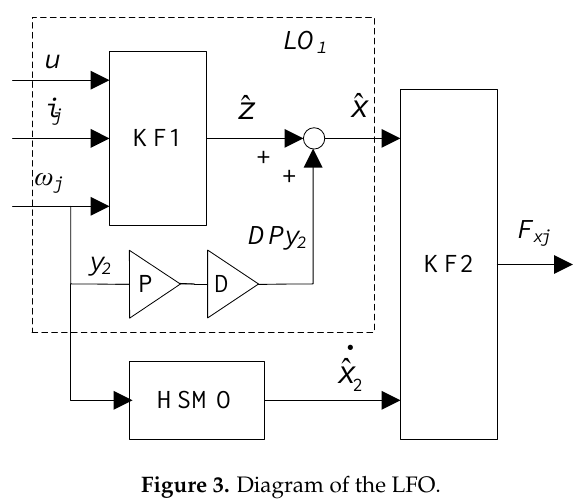
Figure 3. Diagram of the LFO.